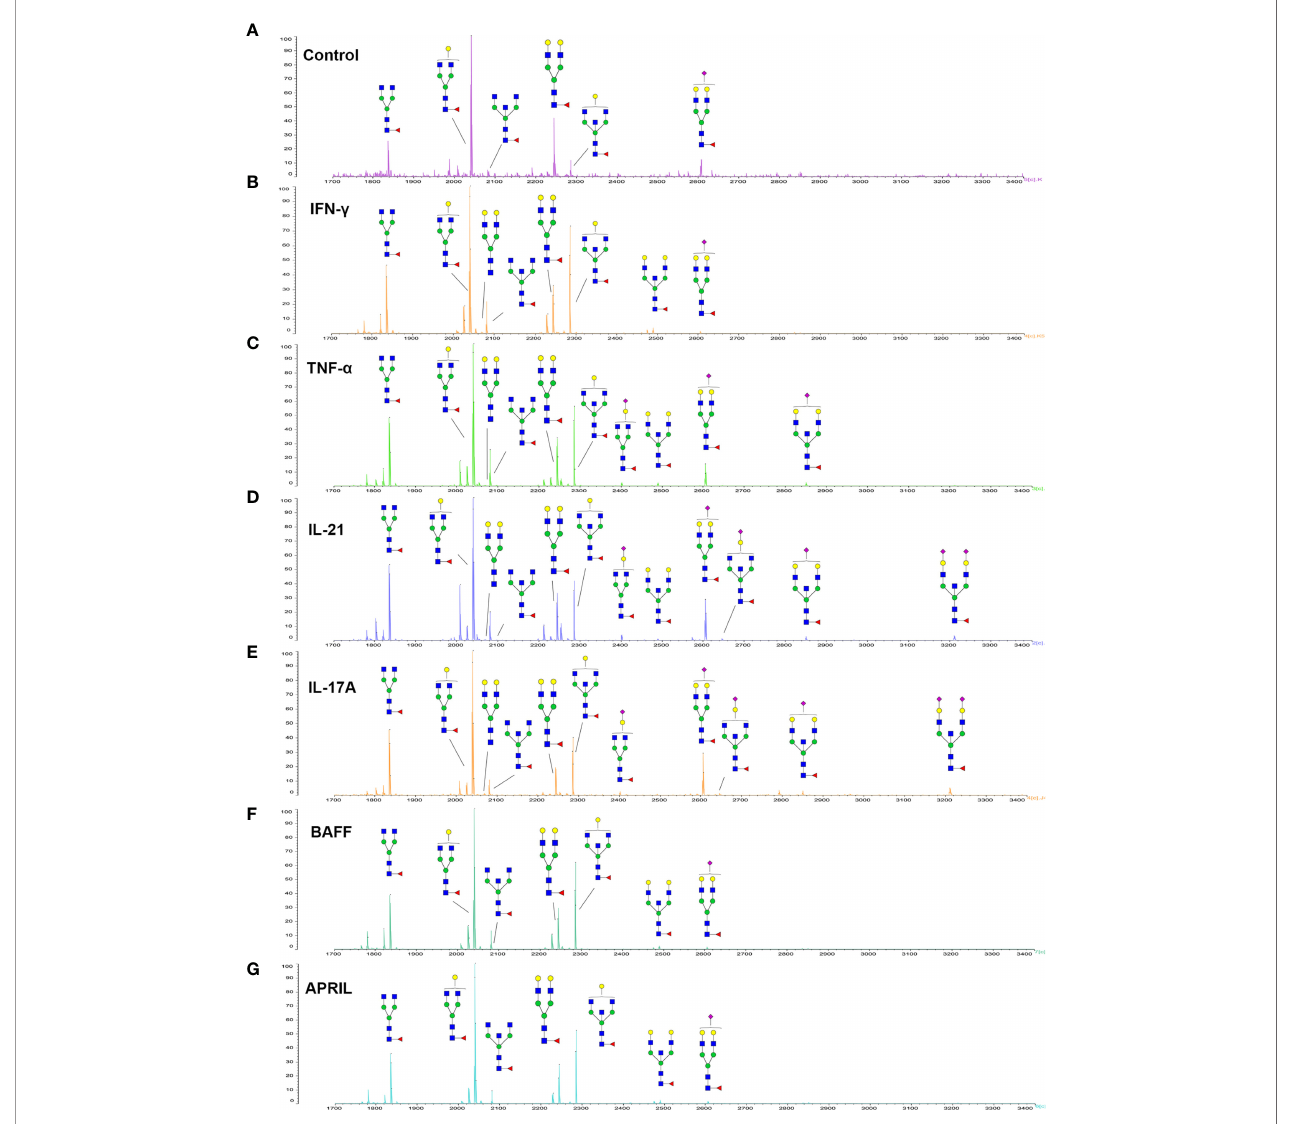
FIGURE 5 | MALDI-TOF-MS spectrum of N-glycans from puri fi ed IgG stimulated by cytokines. (A – G) Glycosylation pro fi les of puri fi ed IgG from the culture medium under control conditions and stimulation with IFN- g , TNF- a , IL-21, IL-17A, BAFF, and APRIL detected by MALDI-TOF-MS at m/z 1700 –